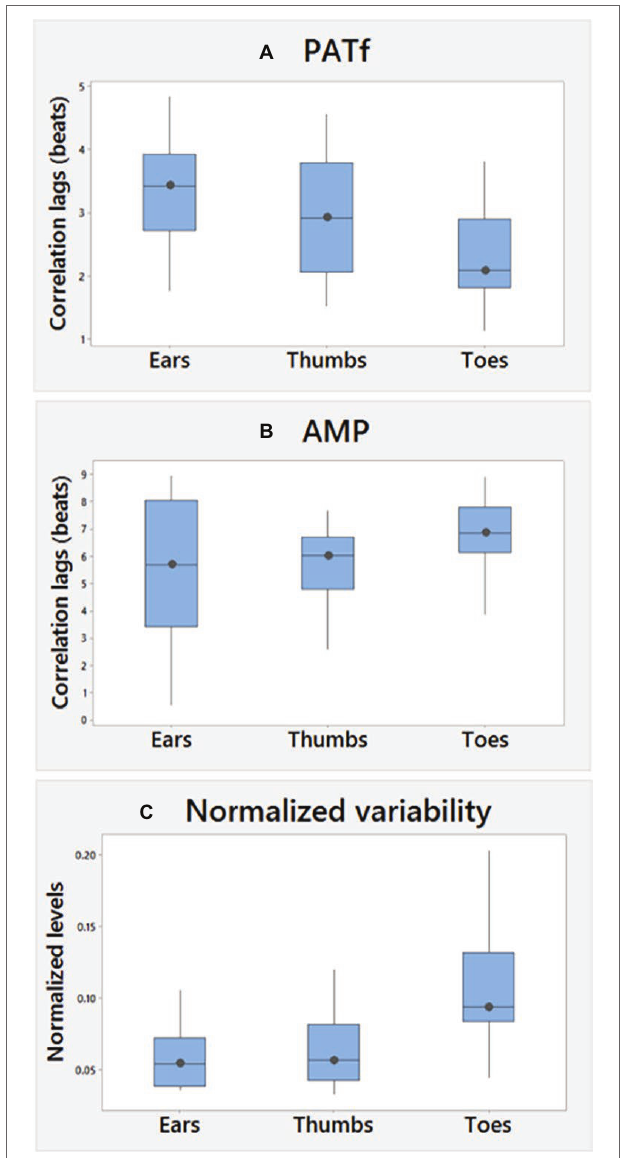
FIGURE 2 | Overall (A) PATf and (B) AMP correlation lags and (C) PATf timing variability normalized to cardiac changes (SD of PATf at each site normalized using the SD of R-R intervals). A positive cross correlation value, i.e., lag means changes in PPG measures lag behind changes in the ECG R-R interval measure during paced